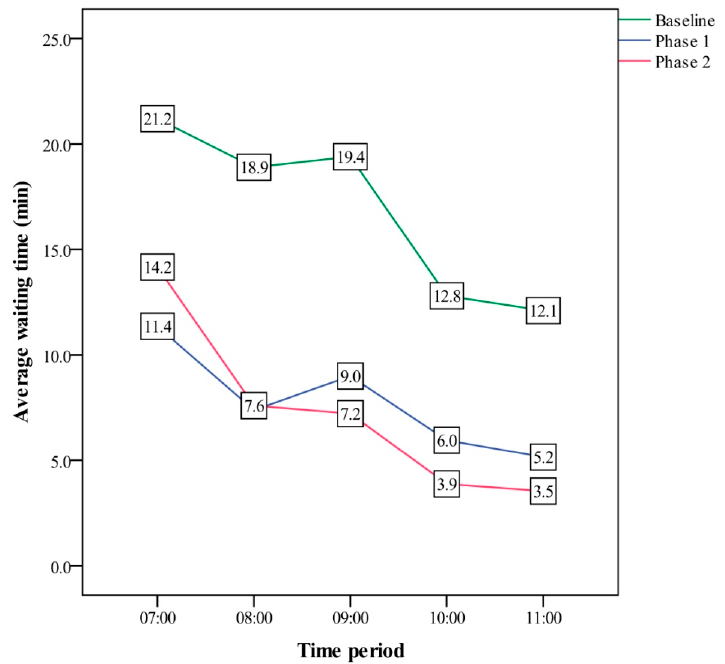
Figure 7. Comparison of waiting time (minutes) at peak times among the three phases.